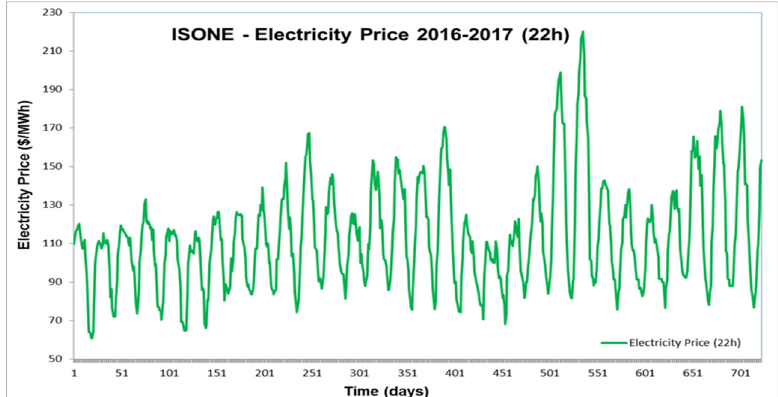
Figure 4. ISO-NE electricity price times—series corresponding to 4 h.